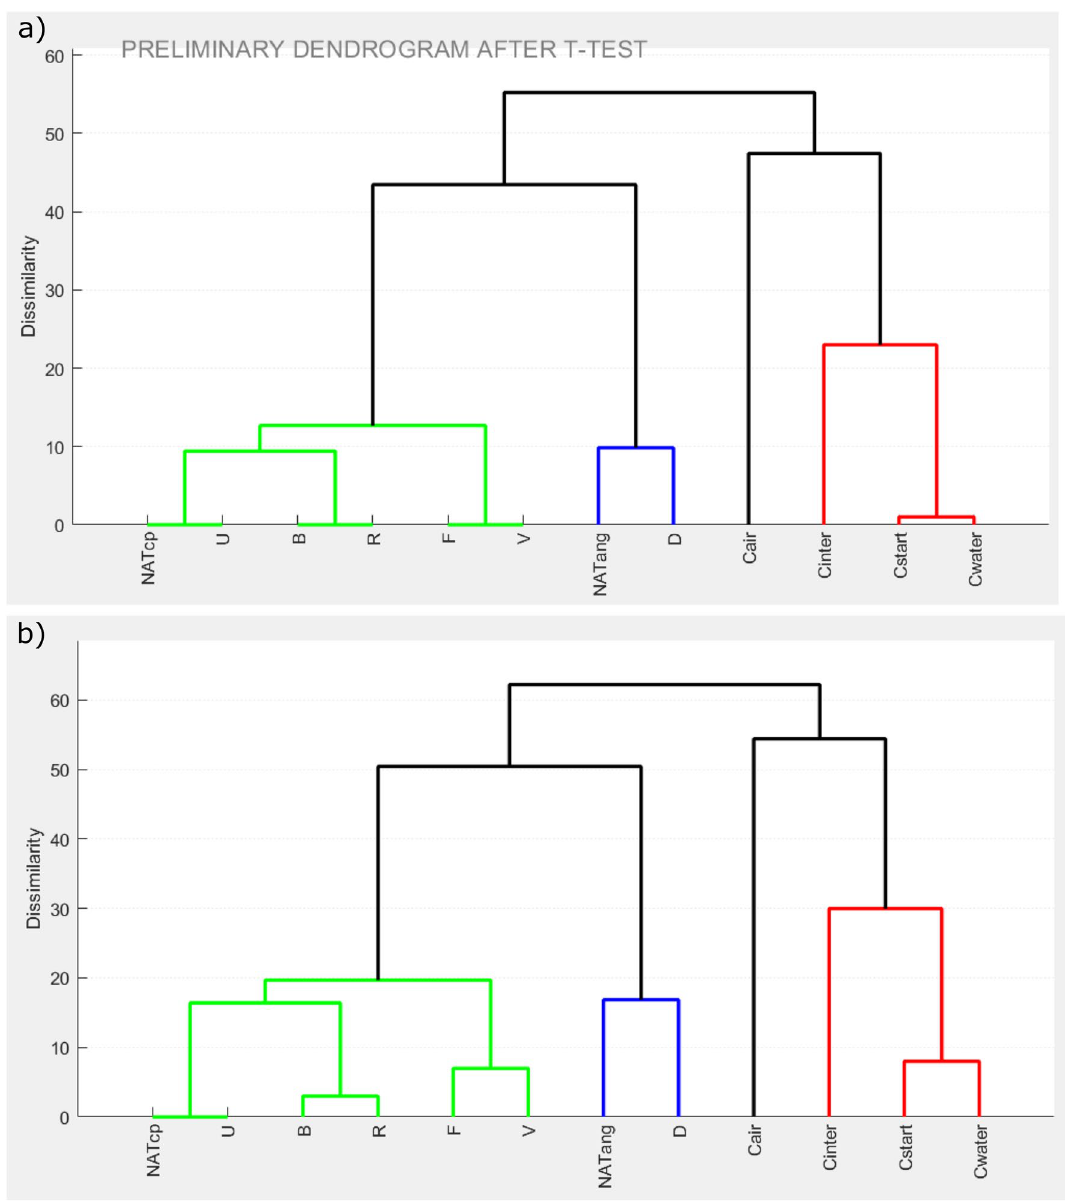
Figure 5. Screenshots showing the output for automatic DAPM via DendroScan. ( a ) Preliminary dendrogram considering dendrograms of all levels and t-tests. ( b ) Final display of DAPM results. In contrast to the upper diagram, results from e-tests are now also